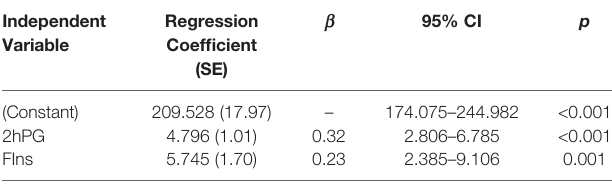
TABLE 5 | Stepwise multiple linear regression analysis with Ectodysplasin A as the dependent variable. Independent Regression Variable Coef fi